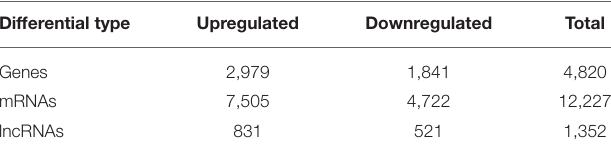
TABLE 1 | PolyA-seq statistics of the different results obtained. Differential type Upregulated Downregulated Total Genes 2,979 1,841 4,820 mRNAs 7,505 4,722 12,227 lncRNAs 831 521